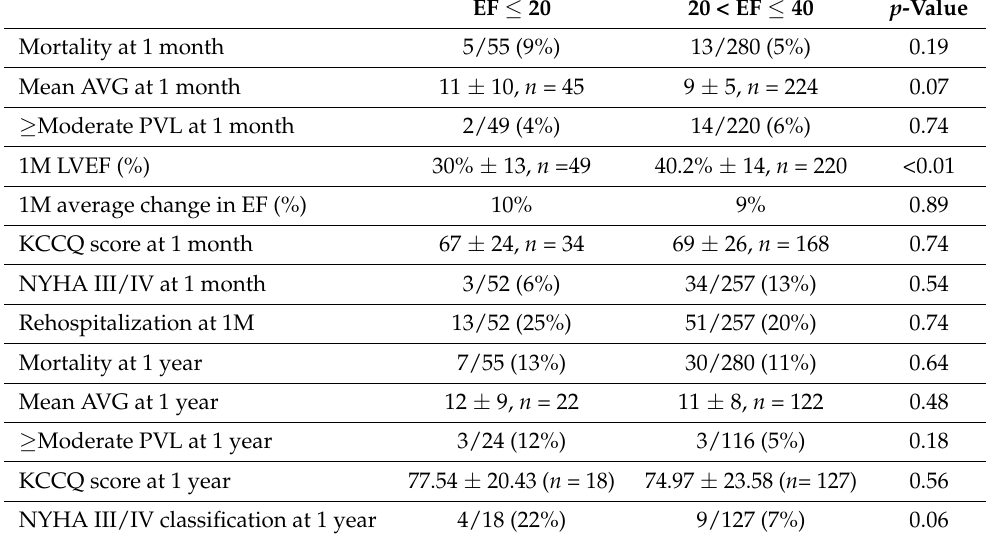
Table 3. One Month and One Year